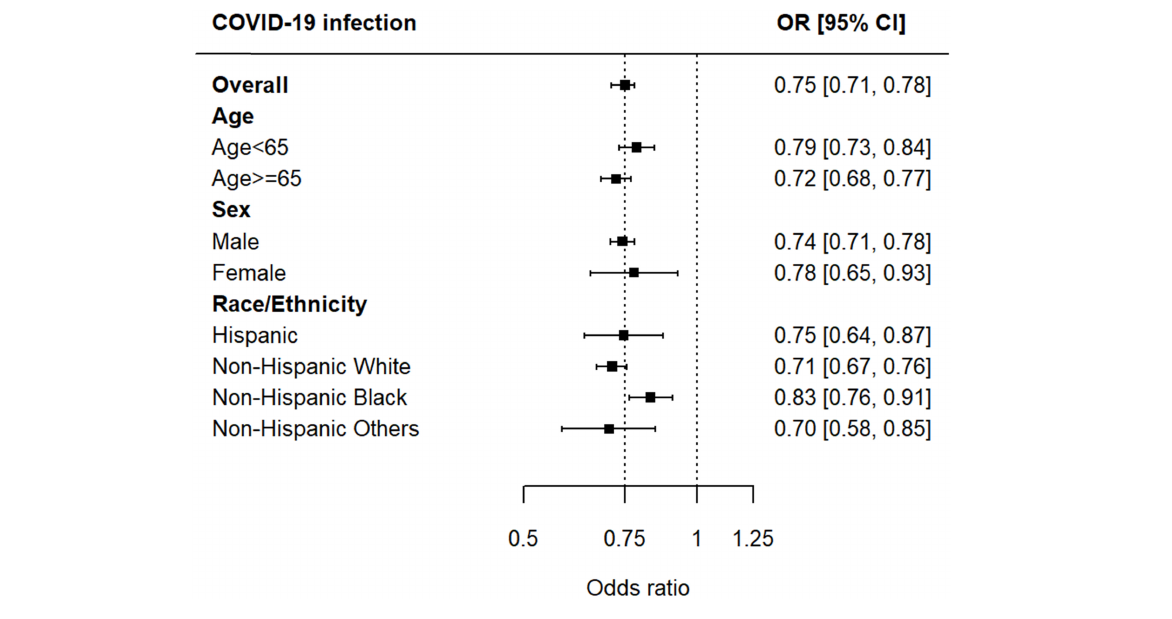
FIGURE3 Associations between iodinated contrast exposure and risk of COVID-19 infection by age, sex, and